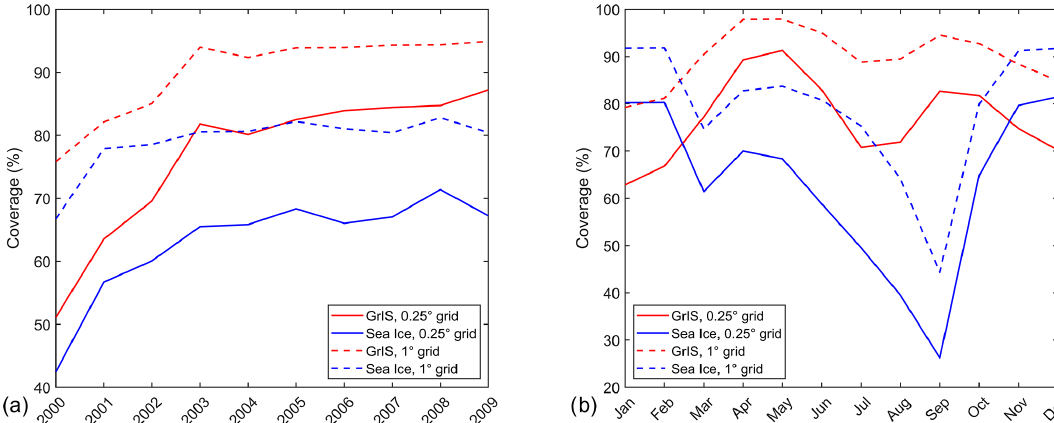
Figure 15. T2m sat coverage averaged for (a) each year and (b) each month for the GrIS and sea ice, and using a grid resolution of 0.25 ◦ and 1 ◦ ,